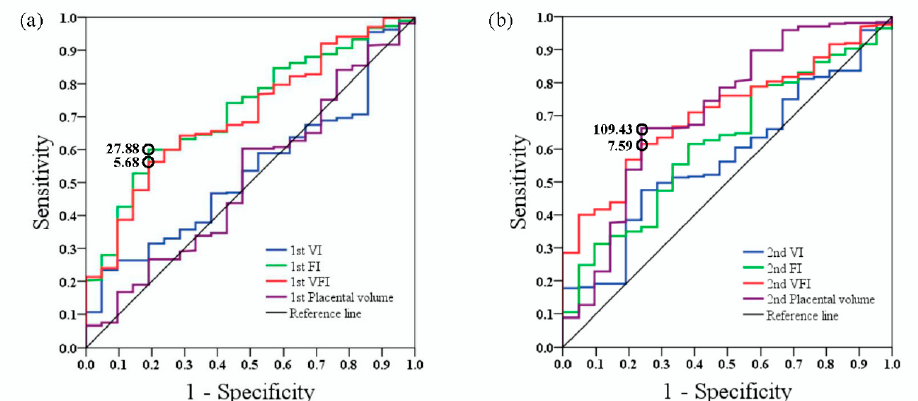
Figure 2. Receiver operating characteristic (ROC) curves of different parameters (VI, FI, VFI, and placental volume) in the ( a ) first and ( b ) second trimesters to predict SGA pregnancies. VI: vascularization index; FI: flow index; VFI: vascularization flow index. The optimum cut-off point (open circle) was defined as the closest point on the ROC curve to the point ( x , y ) = (0, 1), where x = 1-specificity and y = sensitivity.